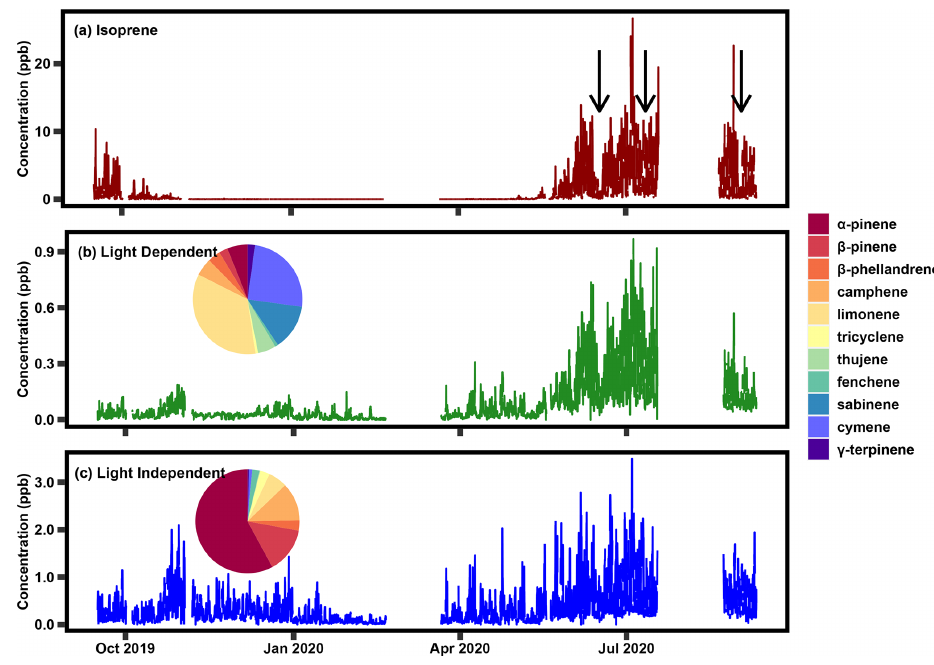
Figure 3. Time series of isoprene concentration and the two positive matrix factorization factors between September 2019 and Septem- ber 2020 and the breakdown of the monoterpene species that contribute to each factor. The black arrows in panel (a) denote the transient periods that are apparent in both the isoprene data (a) and the light-dependent factor (b) .